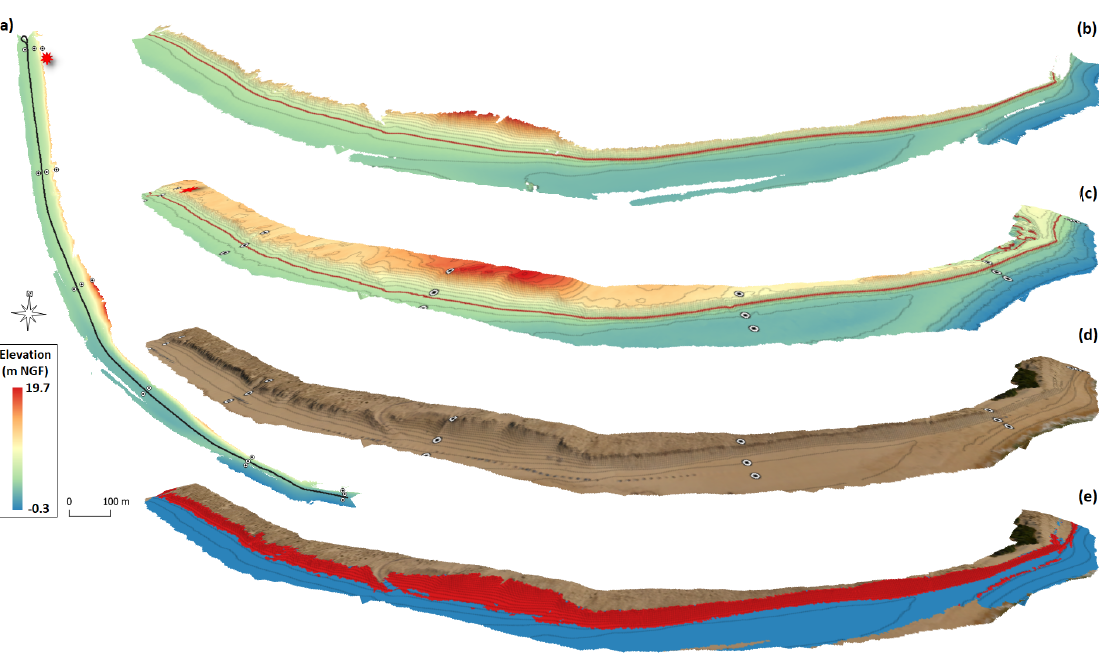
Figure 4. Digital Elevation Models (DEMs). ( a , b ) Regular grid elevation model derived from MLS point cloud. ( c ) Same as ( b ) for the elevation model obtained after triangulating sparse point cloud computed by photogrammetry (ISO_4GCPs+KGCPs). Symbols on ( a , c ) are the same as on Figure 3a; on ( b , c ) isocontours are 1-m spaced with +6 m NGF shown in red. ( d ) Same DEM as ( c ), but draped with the orthophoto generated with the UAS images. ( e ) Same DEM as ( c ), with the red and blue shades corresponding respectively to the steep and flat areas in the MLS-derived